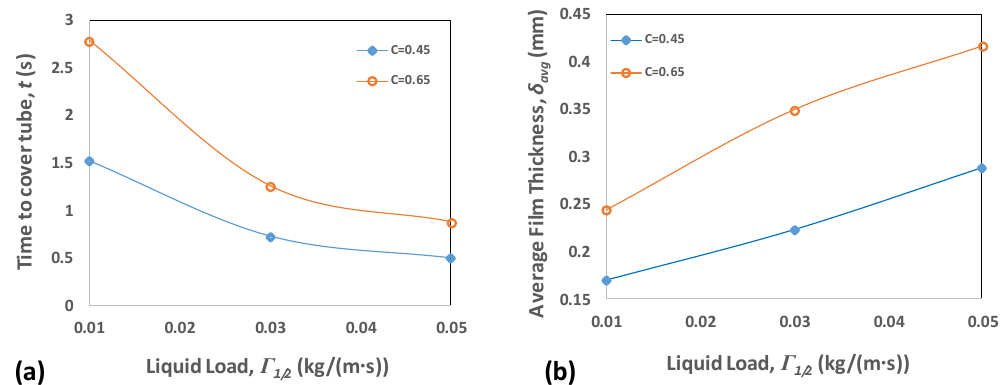
Figure 9. ( a ) Time required for the complete wetting of tube and ( b ) average film thickness for different liquid loads and concentrations.